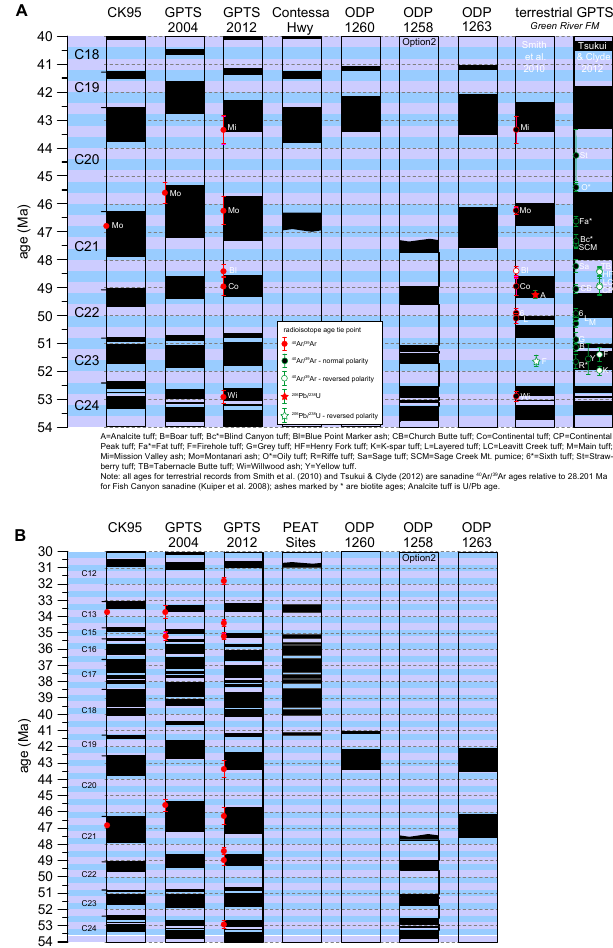
Figure 7. Geomagnetic polarity timescale of CK95 (Cande and Kent, 1995), GPTS2004 (Ogg and Smith, 2004) and GPTS2012 (Ogg, 2012; Vandenberghe et al., 2012) compared to astronomical calibrations of magnetochrons from Contessa Highway (Jovane et al., 2010), PEAT sites (Westerhold et al., 2014), Site 1260 (Wester- hold and Röhl, 2013), Site 1258 (Westerhold and Röhl, 2009; West- erhold et al., 2012) and 1263 (this study) from (a) 40–54Ma and (b) 30–54Ma. In (a) the terrestrial calibration of the GPTS from the Green River Formation (Smith et al., 2010; Tsukui and Clyde, 2012) is also shown. Small red dots with error bars mark the radioiso- topic calibration points used for CK95, GPTS2004, GPTS2012, and Smith et al. (2010); green circles show calibration points for the ter- restrial sections used by Tsukui and Clyde (2012). The overview demonstrates the consistent Eocene coverage from 30 to 54Ma by ODP- and IODP- (PEAT sites) derived stratigraphic data and the discrepancy in the terrestrial